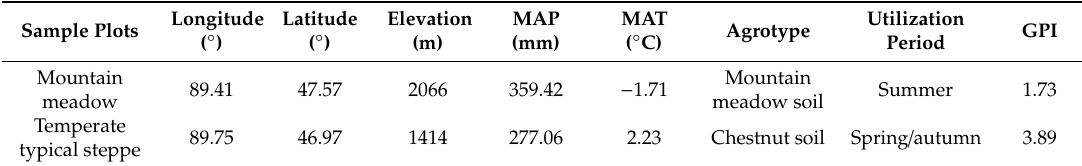
Table 1. The information of the plots.